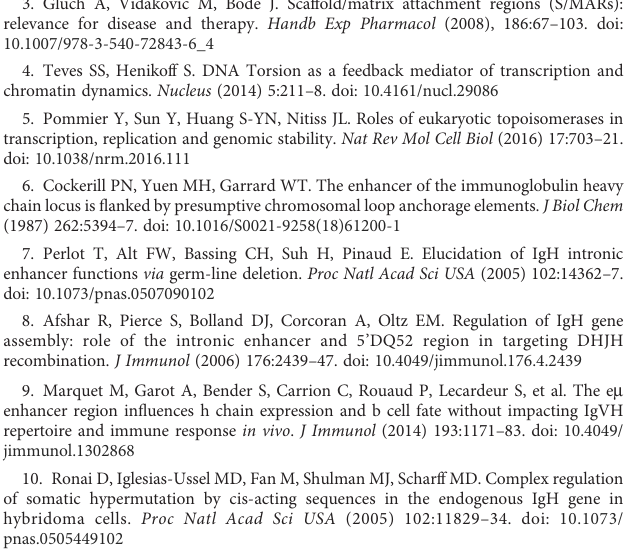
after ampli fi cation, cloning and sequencing by classical Sanger method of DNA extractedfromfromPeyer ’ spatchsortedGCBcells(n=2to3independentsamples corresponding to individual mice or pools of 7 to 12 mice of each genotype). SHM data were calculated after processing individually recombined IgH alleles by IMGT V-Quest software (https://www.imgt.org/IMGT_vquest); numbers of base substitutions identi fi ed as SHM by the software in the FR3 and CDR3 regions are reported in the table and were used to calculate SHM frequencies. SUPPLEMENTARY TABLE 4 SHM data (NGS) from individual mice in genetic backgrounds de fi cient for base excision repair ( Ung -de fi cient) and mismatch repair ( Msh2 -de fi cient). Total number of mutations, total number of bp analyzed and mutation frequencies. (A) Data